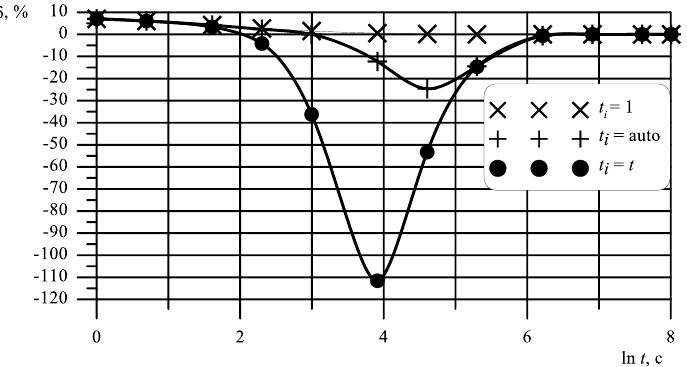
Fig. 4. The errors of solutions to the stretching problem obtained by different methods with respect to the analytical method for different integration steps